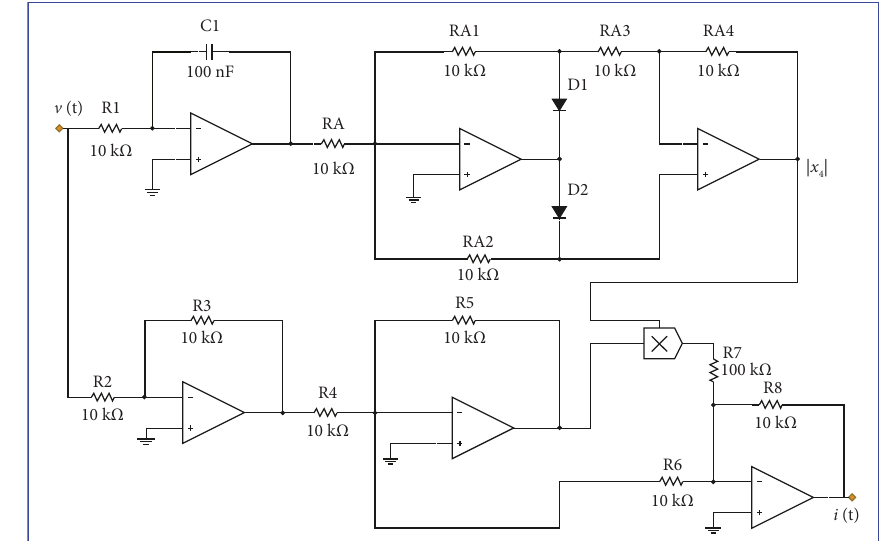
Figure 1: Circuit diagram of absolute memristor.